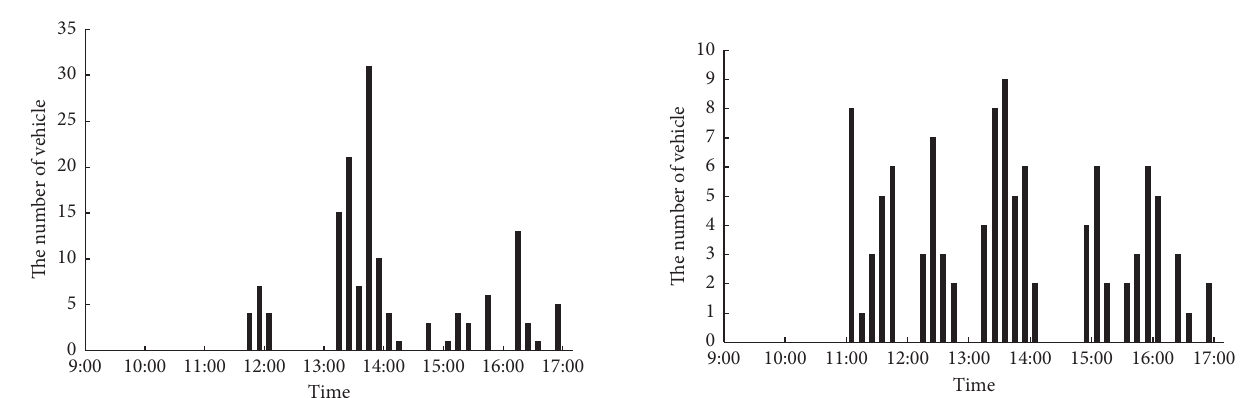
Figure 7: Distribution plan between Song Lei Commercial Building and Triumph Square.